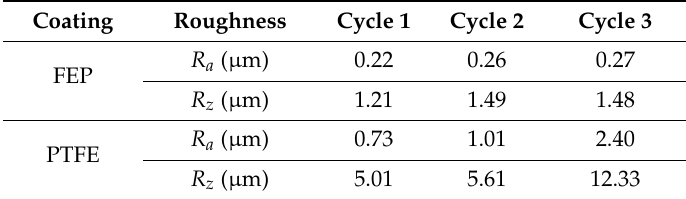
Table 2. Surface roughness of the coatings after the application/polymerization of all layers.